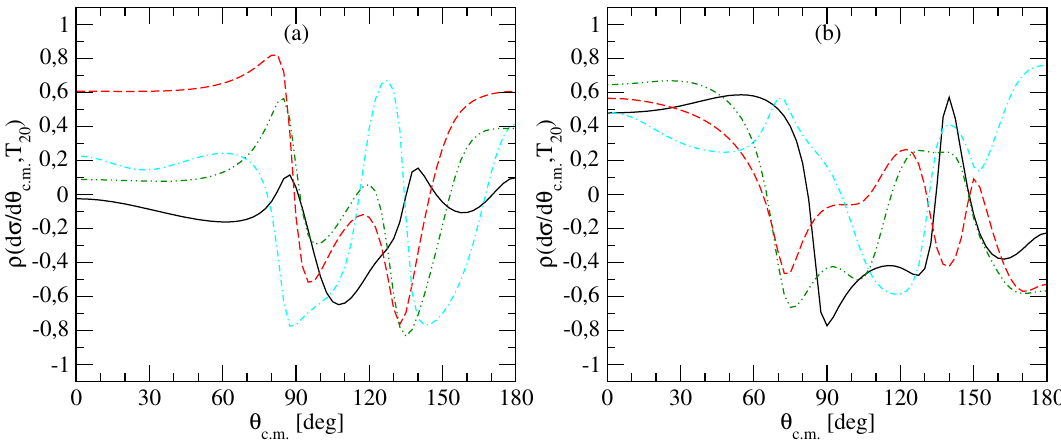
Figure 1: The angular dependence of the correlations coefficient between the dif- ferential cross section d σ/ d θ and the deuteron analyzing power T for the in- c . m . 20 coming neutron laboratory energies E = 13 MeV (a) and E = 65 MeV (b) in the elastic neutron-deuteron scattering. The black solid, red dashed, cyan dot-dash and green dash-dot-dotted lines represent predictions of the SMS chiral N 2 LO, N 4 LO and N 4 LO + forces with Λ = 450 MeV and the OPE-Gaussian potential,